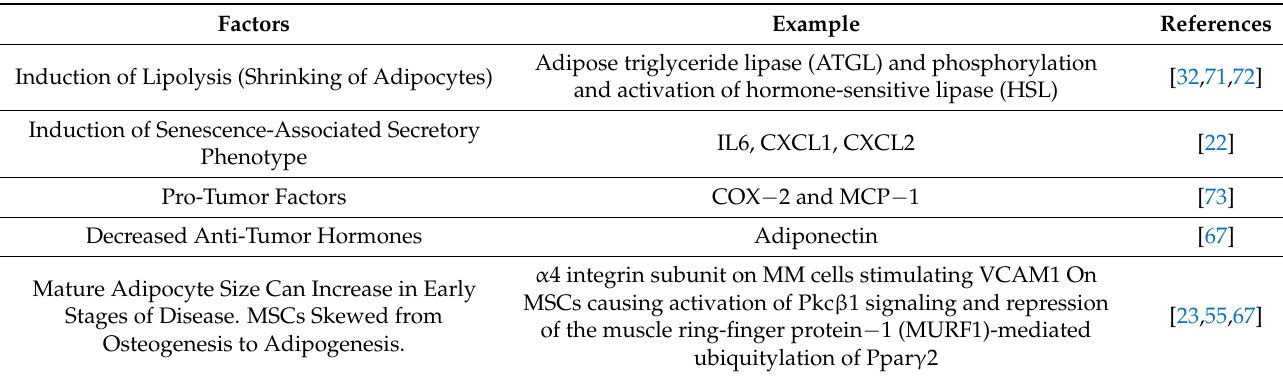
Table 2. Factors and mechanisms through which BMAds are affected by tumor